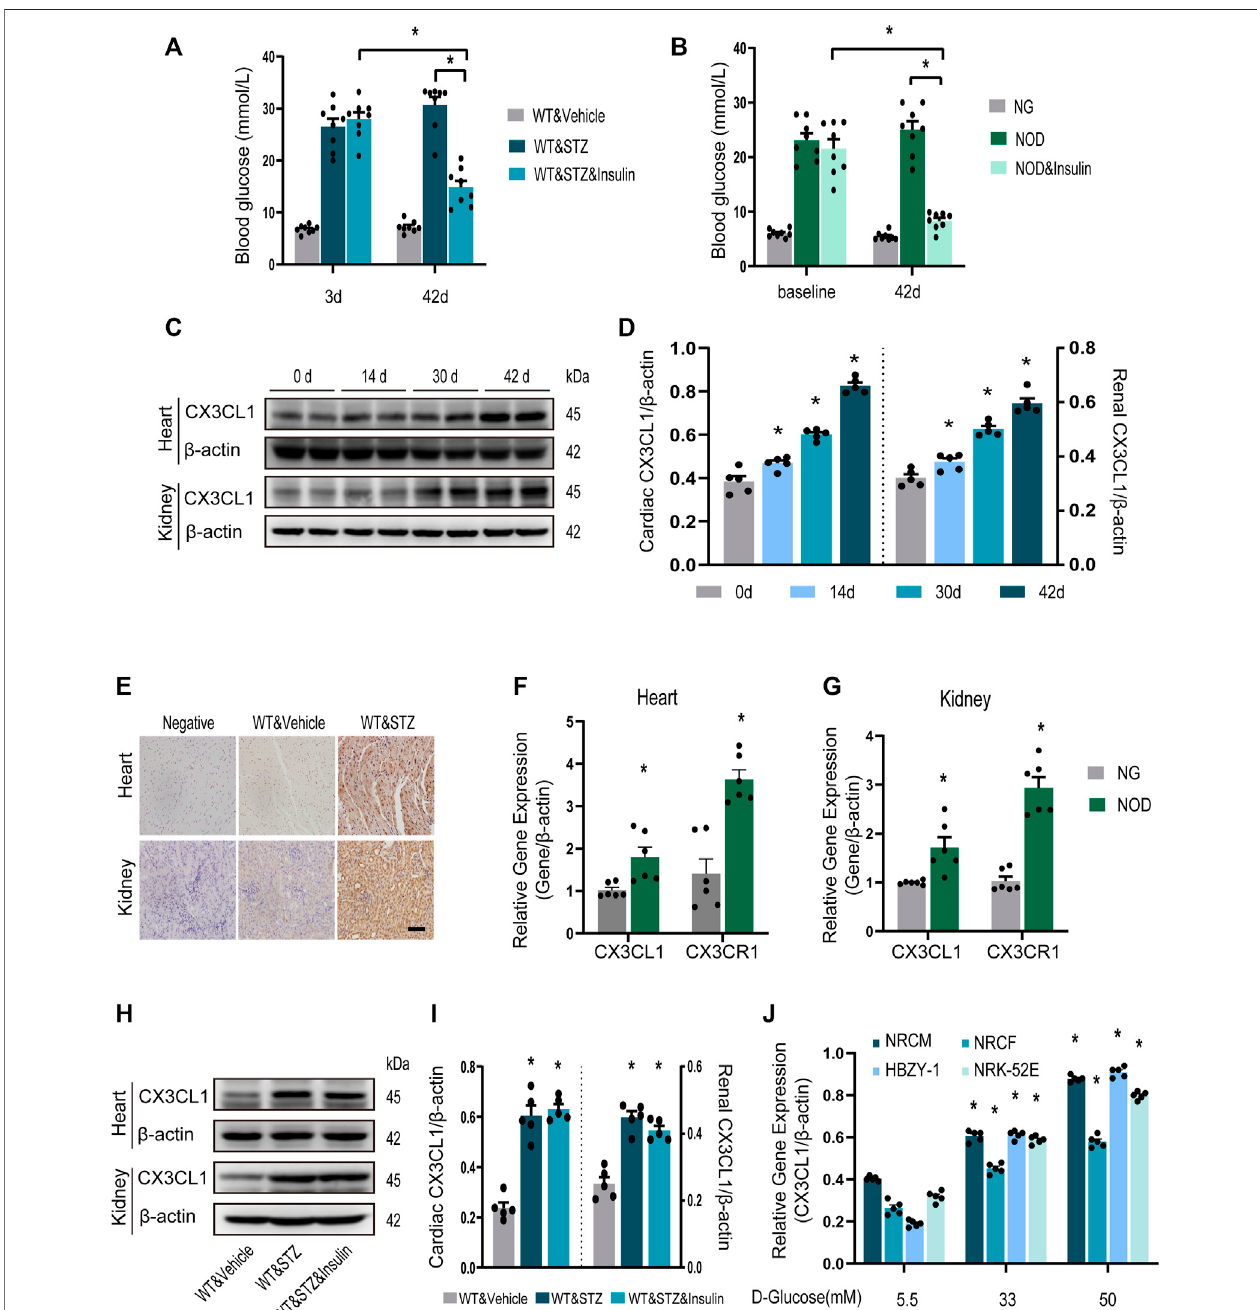
FIGURE1| CX3CL1expressioninresponsetoglucosestimulation. (A) Bloodglucoselevelsat3and42 daysinstreptozotocin(STZ)-inducedDMmice.Insulin treatment was initiated at 28 days after STZ injection and persisted for 14 days. * p < 0.05, n = 8 in each group. (B) Blood glucose levels at 3 and 42 days in NOD mice. The NOD mice were assigned to three groups: normal glucose (NG) group (some mice didn ’ t develop into hyperglycemia), NOD group (with twice random blood glucose level > 20 mM) and NOD&insulin group. Insulin treatment protocol was the same as panel (A) . * p < 0.05, n = 8 in each group. (C) Representative western blotting of CX3CL1 in the heart and kidney tissue of mice at various time points after STZ-injection. (D) Semi-quantitation of CX3CL1 expression in panel (C) . * p < 0.05, vs . the corresponding 0 day, n = 5 per group. (E) Immunohistochemical detection of CX3CL1 expression in heart and kidney tissues of normal or diabetic mice. Scale bar = 100 μ m. (F) Cardiac CX3CL1 and CX3CR1 mRNA expression in NOD mice. (G) Renal gene expression of CX3CL1 and CX3CR1 in NOD mice. * p < 0.05, vs . NG, n = 6 per group. (H) CX3CL1 expression detected by western blotting in heart and kidney tissues from DM mice with or without insulin treatment for 14 days. (I) Semi-quantitation of CX3CL1 in panel (H) . * p < 0.05 vs . WT&Vehicle, n = 5 in each group. (J) mRNA expression of CX3CL1 in neonatal rat cardiomyocytes (NRCM) and fi broblasts (NRCF), two types of renal cell lines HBZY-1 and NRK-52E exposed to different concentrations of glucose medium for 3 days.* p < 0.05 vs .5.5 mMgroup, n =5ineachgroup.Experimentspresentedinpanels (A) , (B) , (D) , (I) ,and (J) wereanalyzedusingone-wayANOVAfollowedby Bonferroni ’ s post hoc test. Experiments presented in panels (F) and (G) were analyzed using two-tailed unpaired t -test.